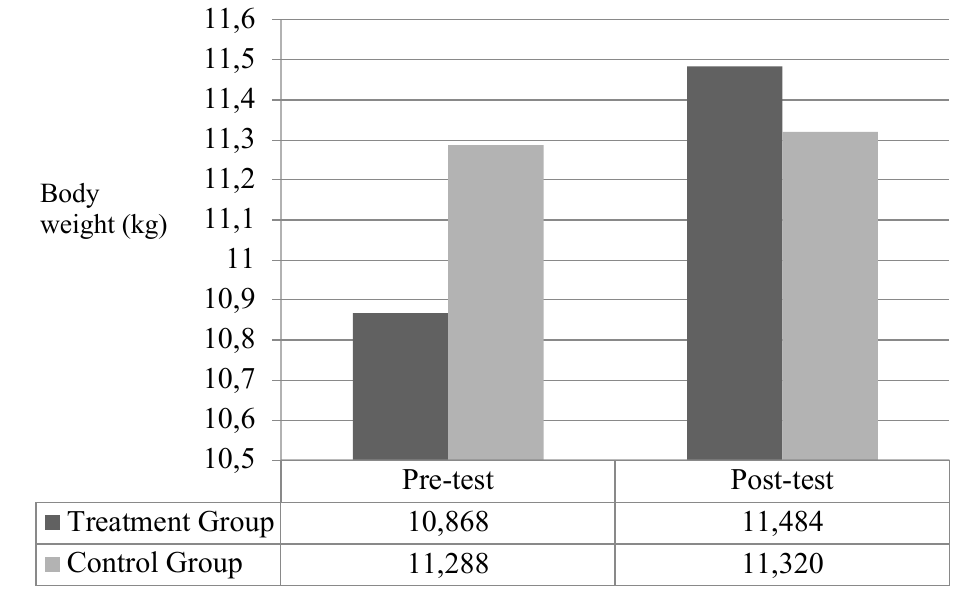
Figure 2. Increase of average body weight of subjects before and after the intervention in the treatment and control